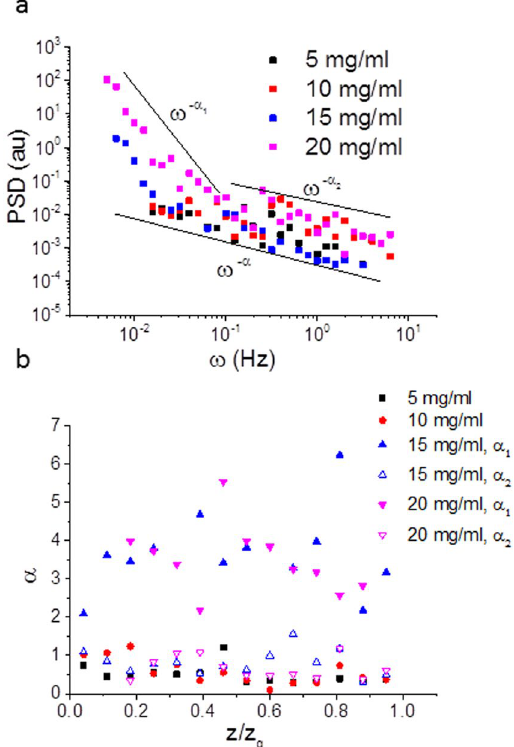
Figure 6. ( a ) Power spectral density (PSD) as a function of frequency ( ω ) of the velocity fluctuations measured for four different concentrations of high salt DNA solution (5, 10, 15, 20 mg/mL), all with an applied shear rate of 60 s − 1 . ( b ) Values of the power law exponent ( α ) of the power spectral density ( P ( ω ) ~ ω −α ) as a function of normalised distance ( z / z g ) across the rheometer gap. Open (no turbulence) and closed (turbulence) symbols are used to distinguish between the two observed power law dependencies when turbulence occurs.